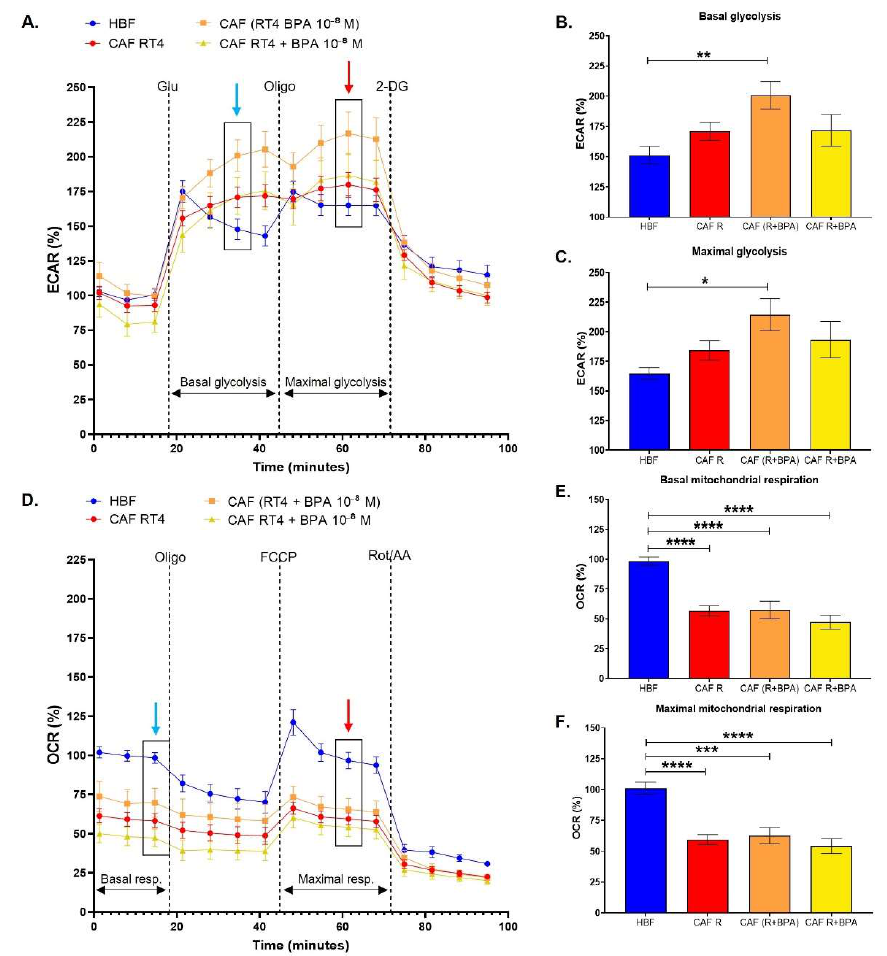
Figure 3. Cancer-associated fibroblasts conditioned by non-invasive bladder cancer cells exhibit a metabolic switch characterized by a decreased mitochondrial metabolism and increased glycolysis accentuated by BPA. ( A – C ) ECAR and ( D – F ) OCR were determined using the XFe96 Extracellular Flux Analyzer in cancer-associated fibroblasts (CAFs). Healthy human bladder fibroblasts (HBFs) were induced into CAFs over 8 days with conditioned media from non-invasive cancer cells (RT4) glycolytic capacity, ( E ) basal mitochondrial respiration and ( F ) maximal mitochondrial